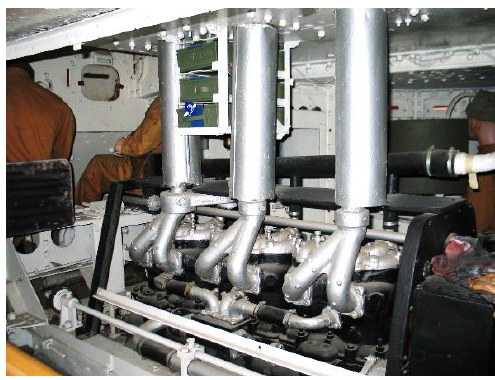
Fig. 1. The Daimler – Knight engine in the Mark II tank (The Tank Muse- um at Bovington Camp in Dorset, photo by the